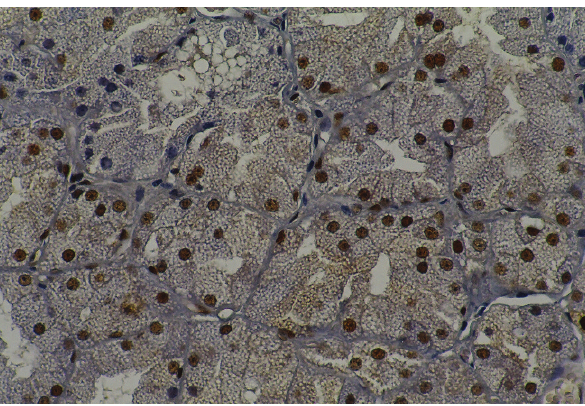
Figure 2 - Immunohistochemical staining of PCNA on epithelial cells (FP60, original magnification